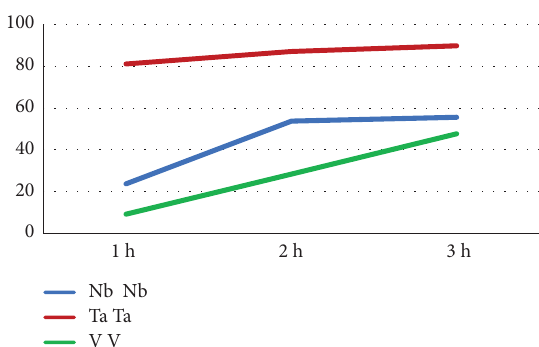
Figure 7: Elemental composition (wt.%) of coating Nb, Ta, and V at diferent sputtering times using the EDS